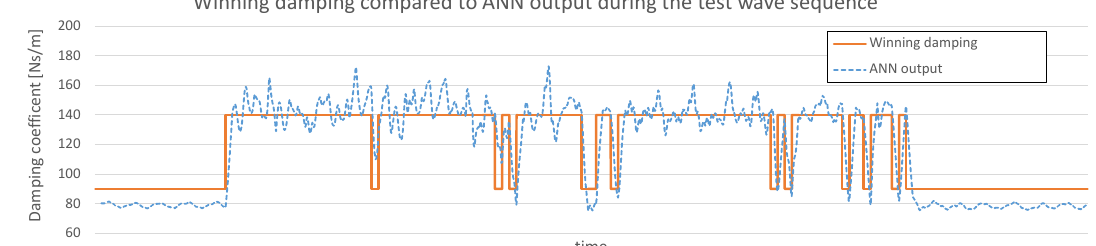
Figure 8. Winning damping of both constant damping controls (orange, solid line) compared to the output for the same input of the ANN (moving average, blue dotted line). To increase readability the ANN output is represented by a moving average of 100